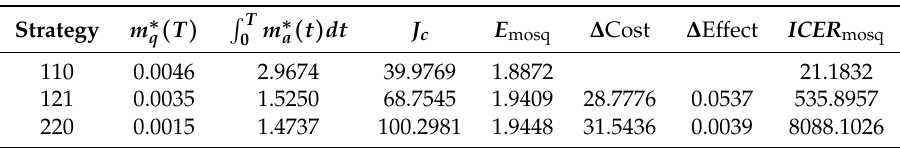
Table 6. ICER calculation for the remaining strategies with respect to their effects on suppression of the mosquito population, E mosq